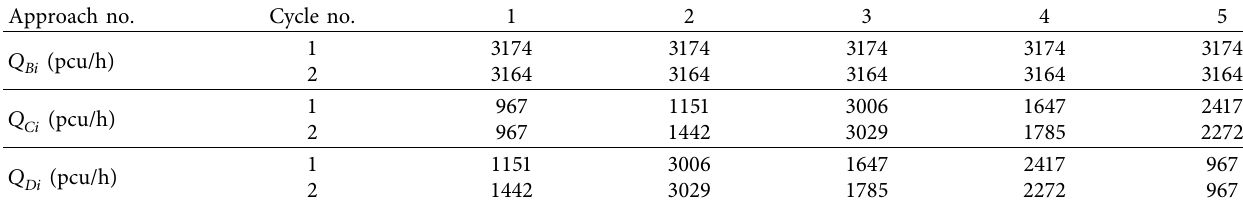
Table 3: Te actual capacity of each approach carriageway of the target roundabout. Approach no.